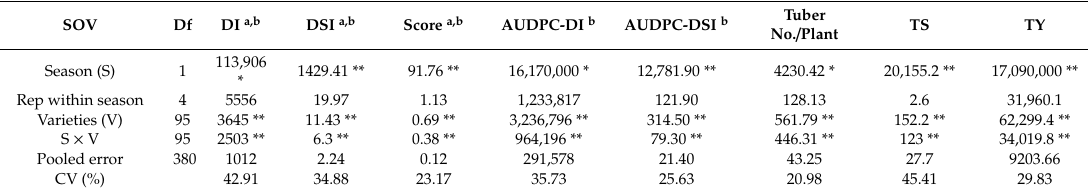
Table 2. Mean squares for disease incidence (DI), disease severity index (DSI), disease score (Score), area under disease progress curve of disease incidence (AUDPC-DI), area under disease progress curve of disease severity index (AUDPC-DSI), number of tubers / plant, tuber size (TS), and tuber yield (TY) of 96 Jerusalem artichoke varieties in early rainy and late rainy seasons.